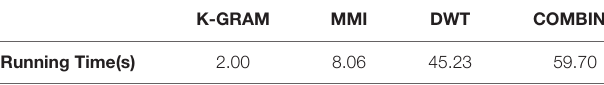
TABLE 5 | Running time of all feature extraction methods. K-GRAM MMI DWT COMBINE Running Time(s)